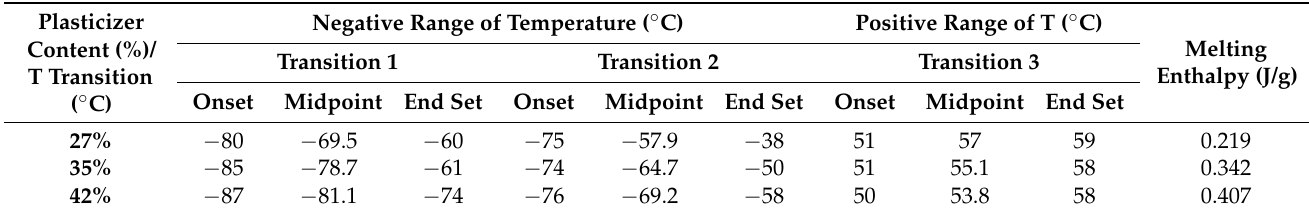
Table 2. The transitions between − 87 ◦ C and 90 ◦ C of the binary starch-based blends.